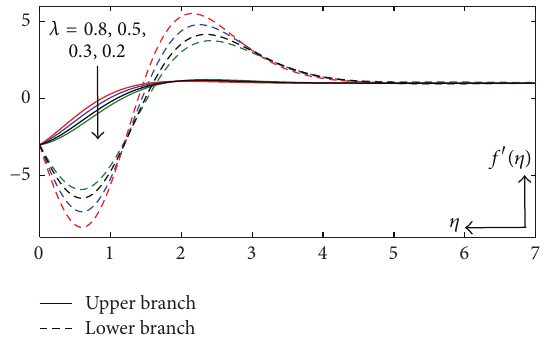
Figure 12: Temperature profiles for various values of 𝛾 with 𝑠 = −3 , 𝜆 = 0.5 , 𝑀 = 0.2 , and Pr = 3 .